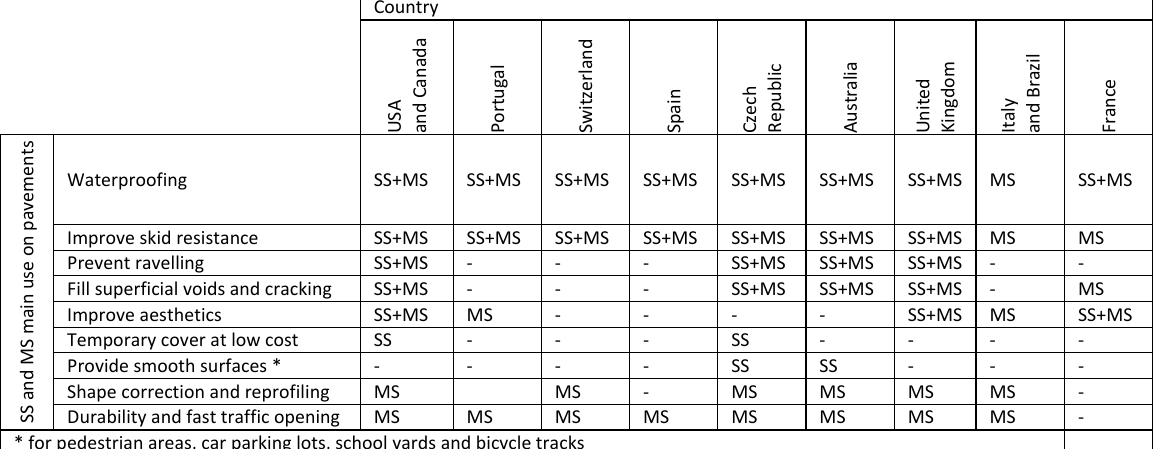
Table 4. Main functions of slurry seal (SS) and microsurfacing (MS) in different countries.